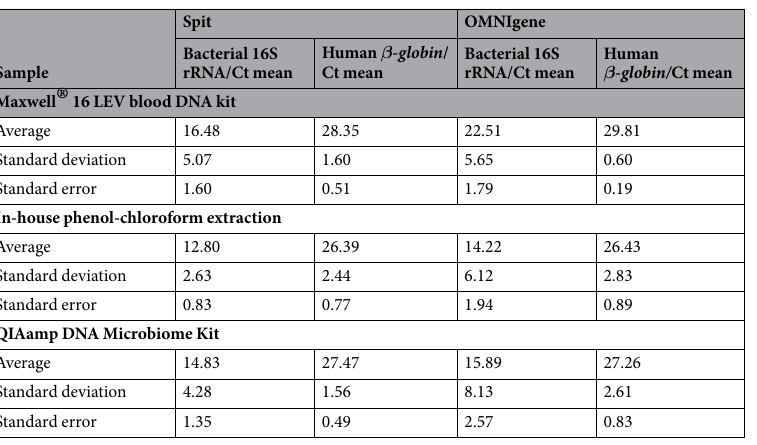
Table 1. Bacterial 16S rRNA and human β -globin qPCR statistical summary for the extracted gDNA (for all three extraction